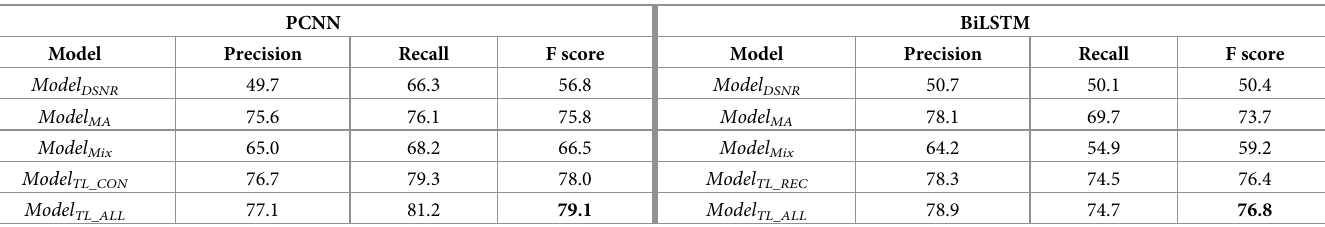
Table 2. Results of deep learning models on PPI.